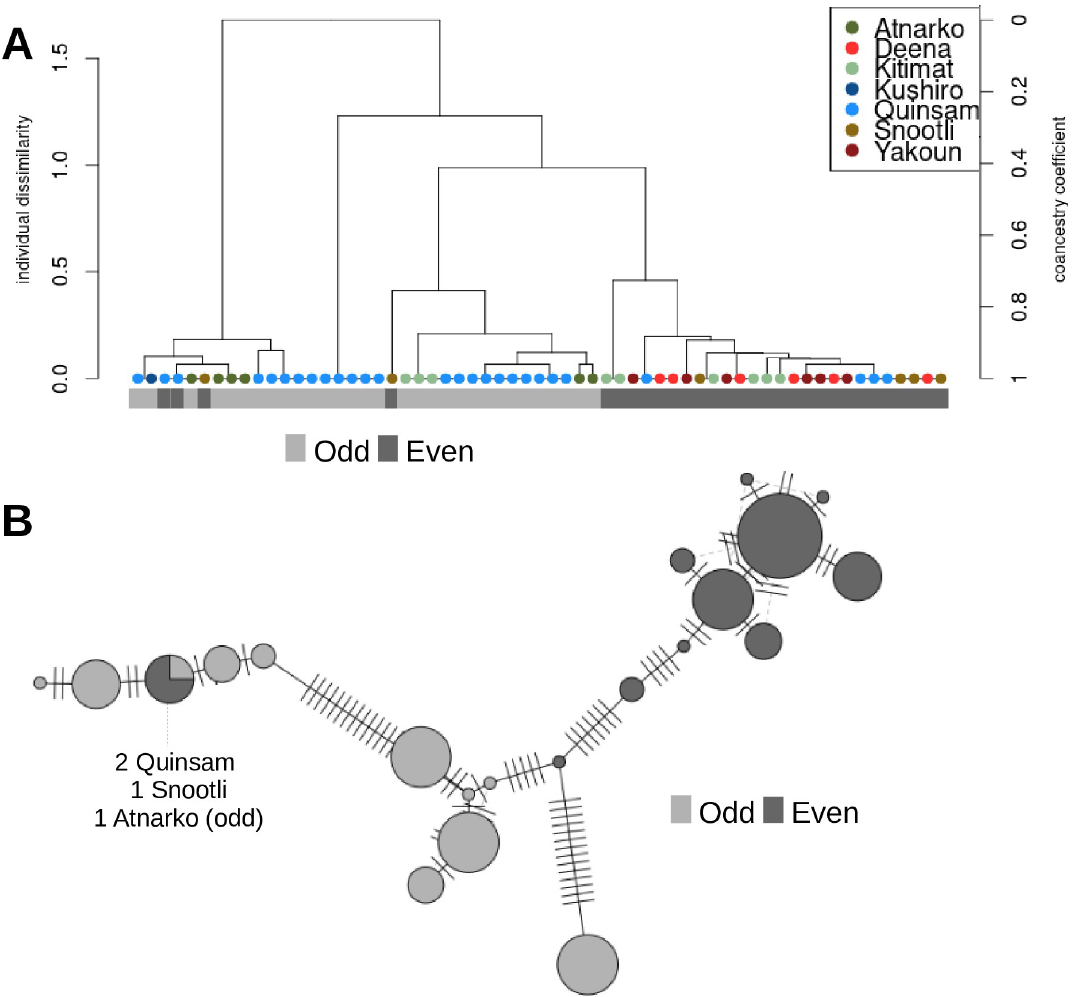
Fig 4. Whole mitochondrial genome comparisons between lineages. A) A dendrogram based on full mitochondrial sequences. The y-axes show dissimilarity scores on the left and coancestry values on the right, which were used to cluster individuals. Year-class/ lineage is specified below the dendrogram. B) A full mitochondrial genome haplotype network is shown for the 21 unique haplotypes identified. River names are shown for the haplotype shared between lineages.